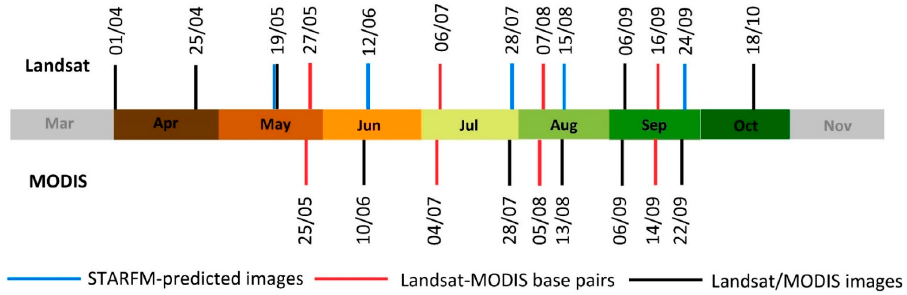
Figure 7. The details of images (MODIS and Landsat) used in the study, including the data used for the STARFM and phenology-based algorithm.